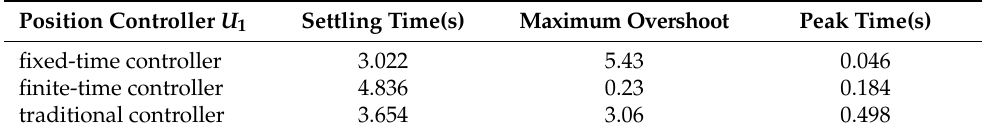
Figure 15. Control input U 1 of different controllers. Table 5. Summary and comparison of attitude subsystem controllers